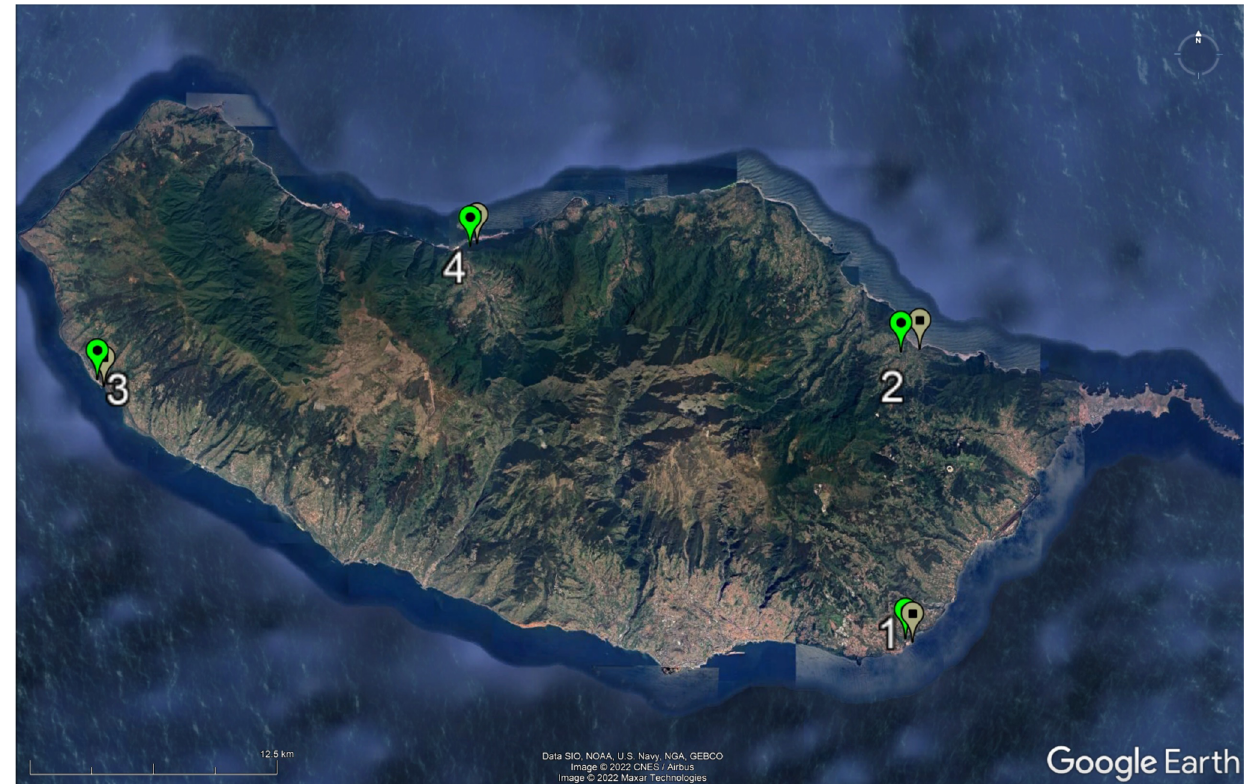
Fig. 5 Sample sites on Madeira. Google Earth Pro v.7.3.4.8642 image showing the four sampling localities (1 – 4). At each locality, lizards were sampled from one beach (light green placeholder) and one inland (grey placeholder) site. Latitudes and longitudes are proved in the Supplementary